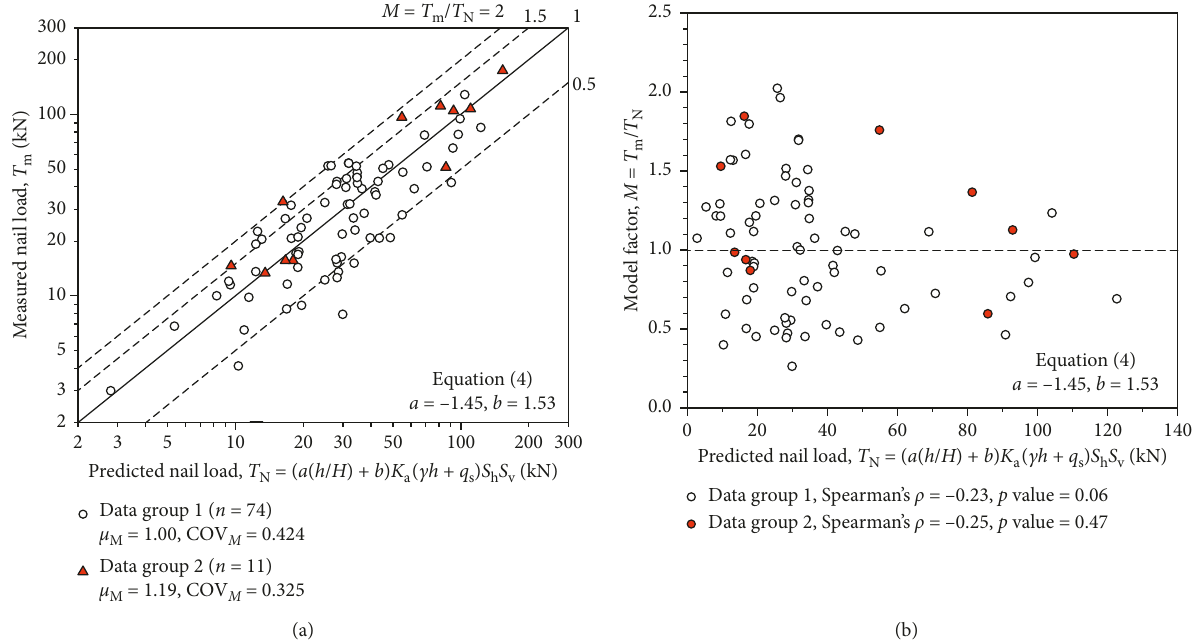
Figure 4: Analyses of Equation (4) using different data groups: (a) measured versus calculated nail load; (b) model factor versus calculated nail load.